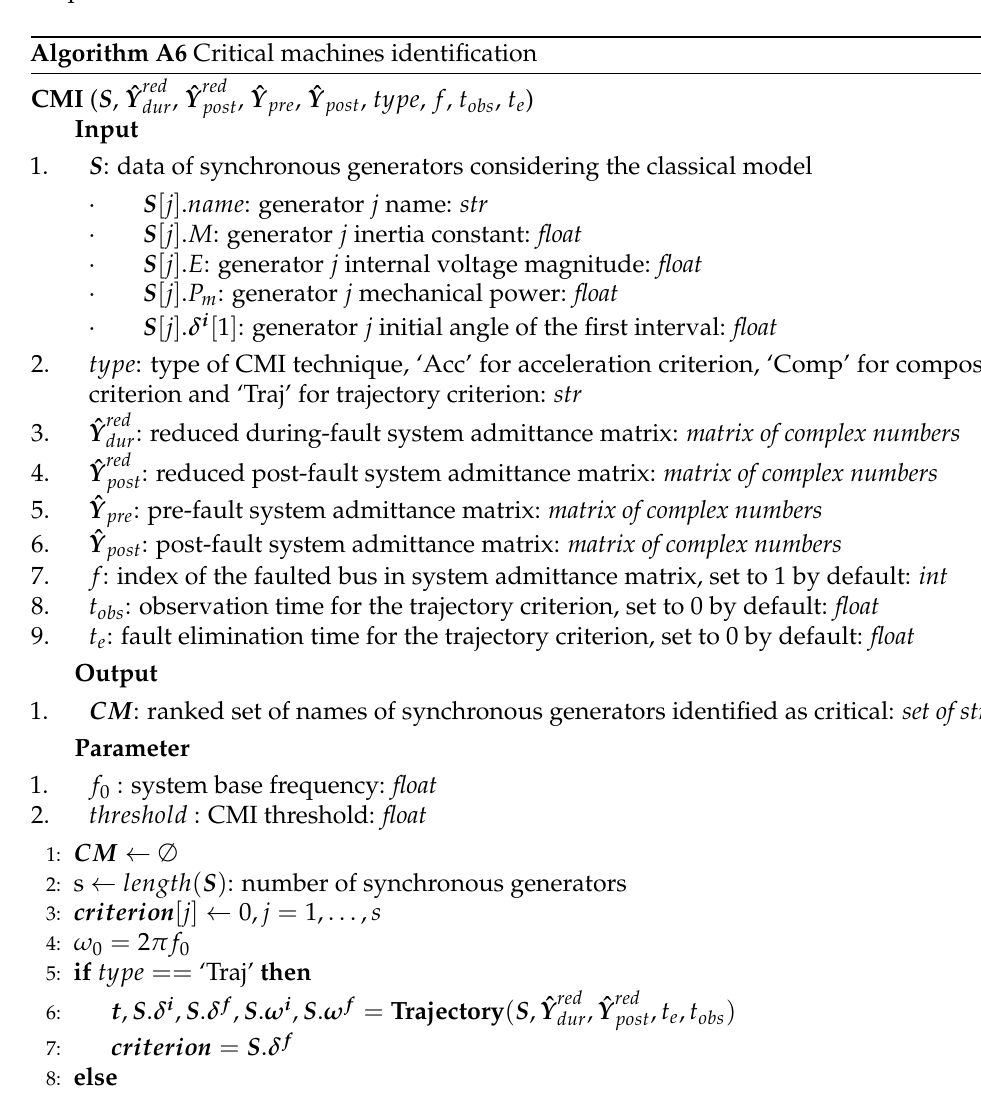
Algorithm A6 pseudocode details the function to identify a ranked list of critical